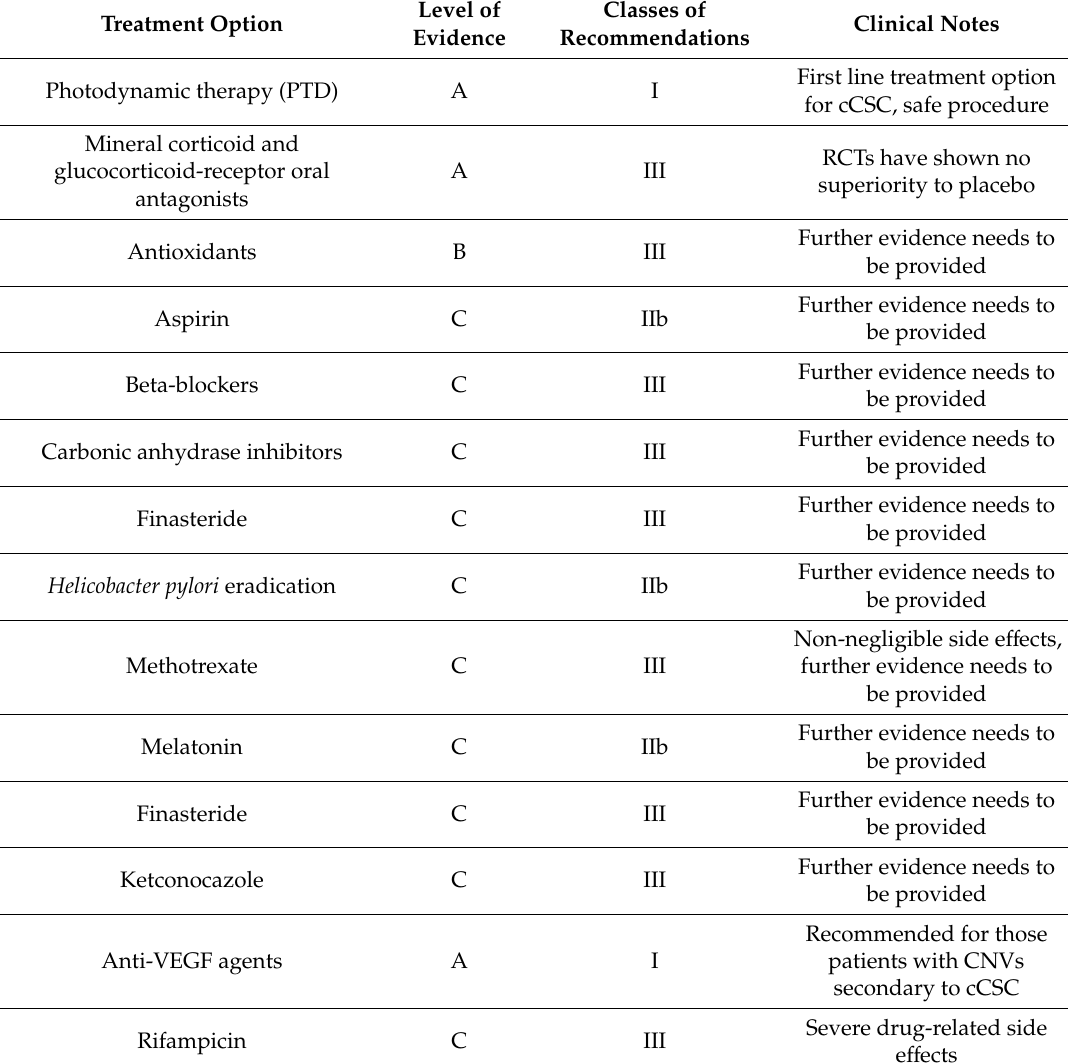
Table 1. Levels of evidence of the main pharmacological treatment options investigated for the treatment of central serous